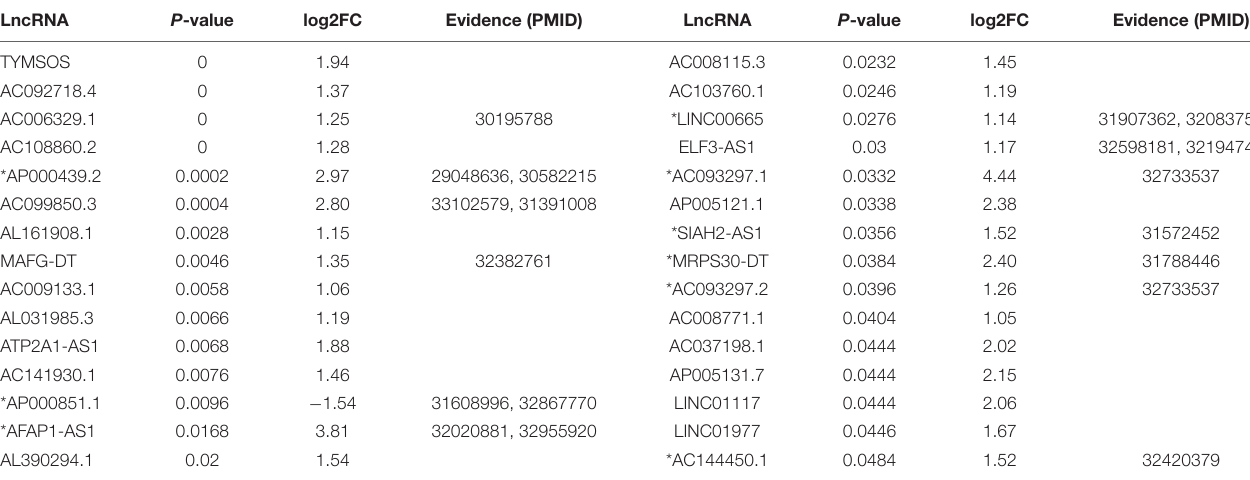
TABLE 2 | Risk lncRNA